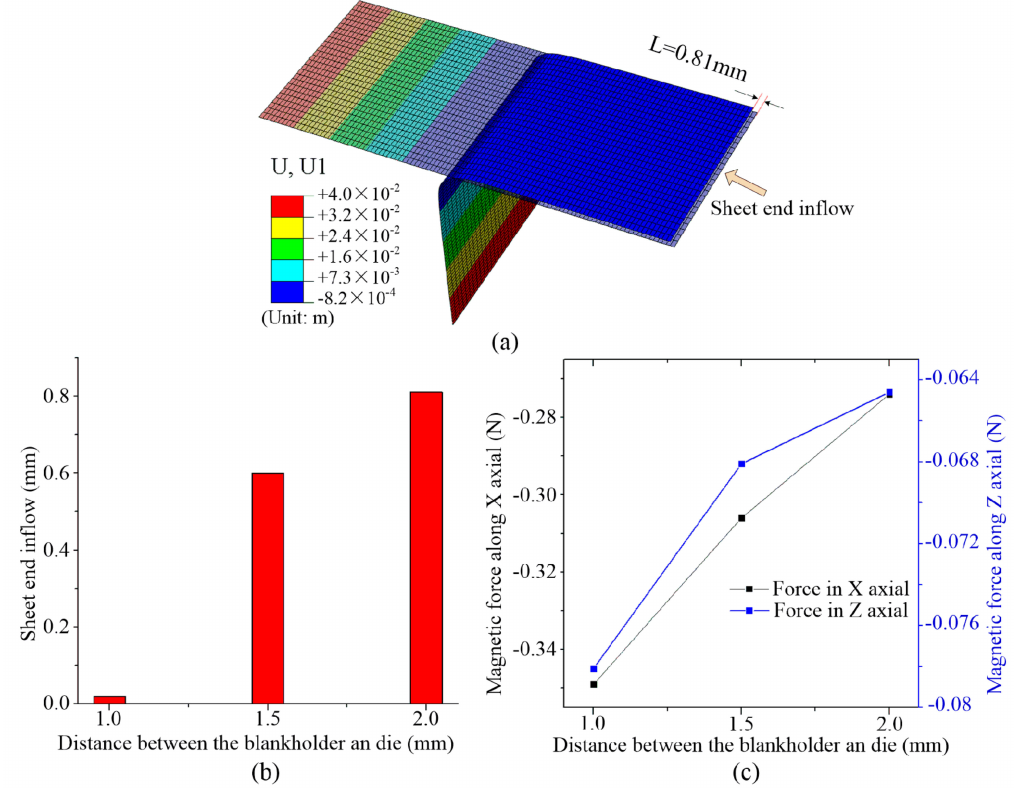
Figure 9. E ff ect of distance between the blank holder and die on ( a ) 3D inflow under h is set to 2 mm, ( b ) inflow at node 3067, ( c ) magnetic force at node